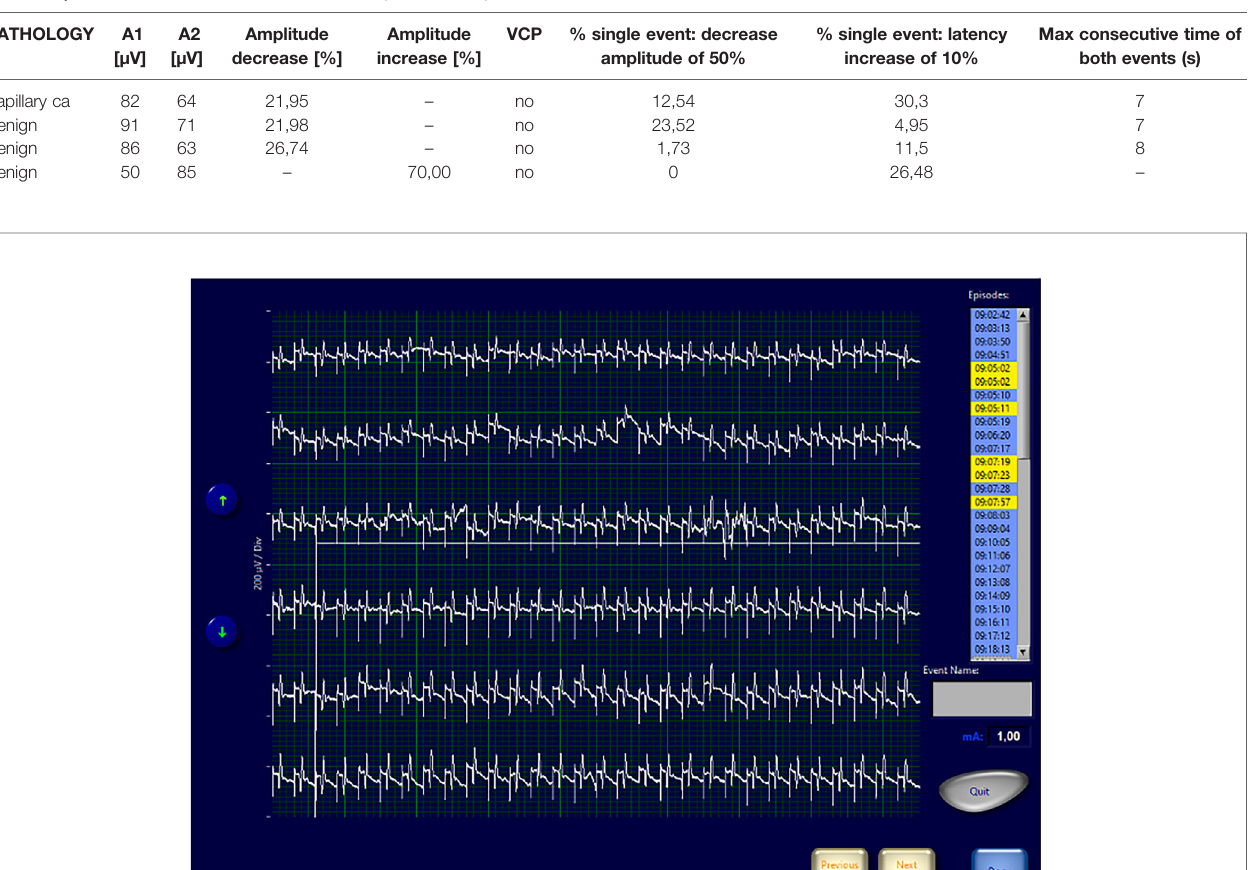
TABLE 2 | Main characteristics of waveform with amplitude <100 µV.